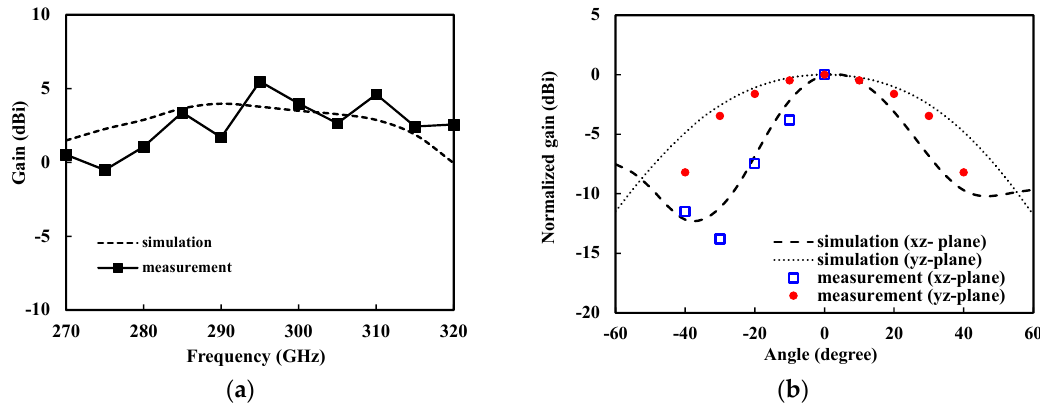
Figure 12. Measured performance of the fabricated antenna. ( a ) Gain as a function of frequency; ( b ) Radiation pattern at a peak gain frequency (295 GHz). Simulation results include the probe tip. Table 2. Comparison of the reported Si CMOS on-chip antennas operating around 300 GHz.